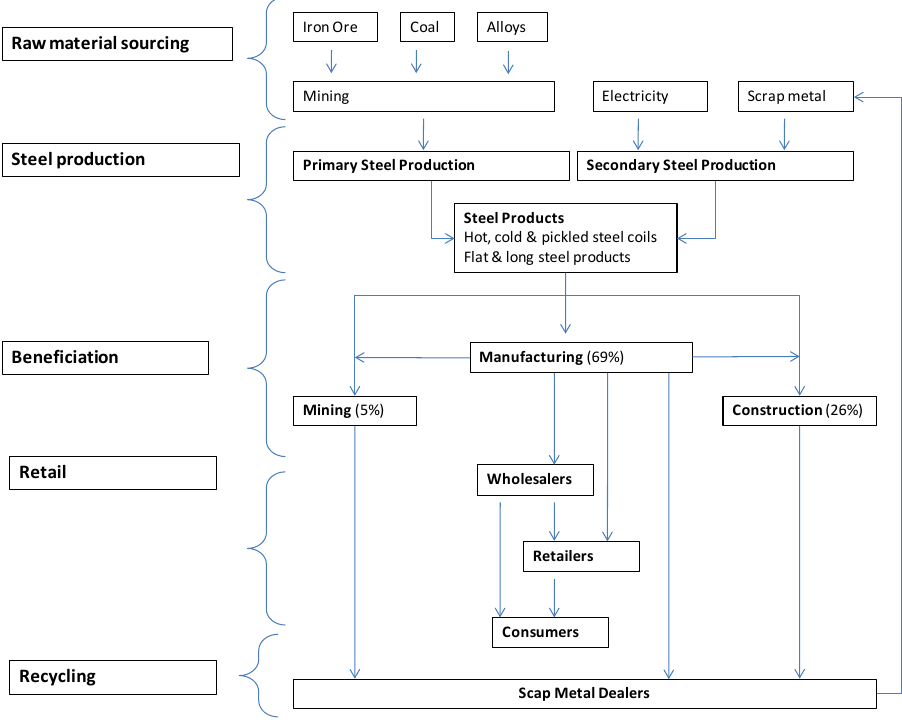
FIGURE 3: Diagrammatic representation of the South African steel value chain Source: The World Steel Association